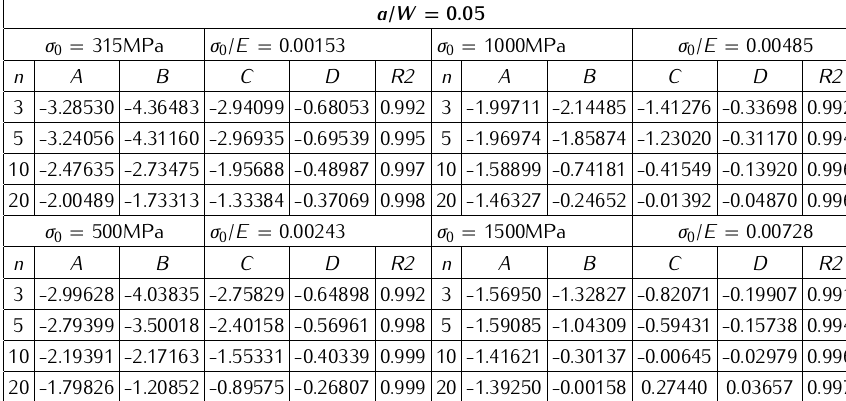
Table 8. The coefficients of equation (13) for SEN(T) specimen with the crack length a / W =0.05.